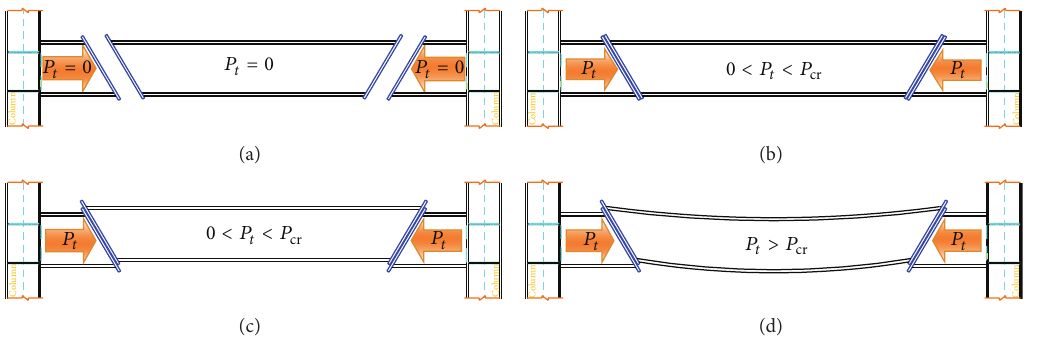
Figure 4: Beam with slant bolted end-plate connection subjected to temperature increase. (a) Stage 1: beam behaviour before increase in temperature. (b) Stage 2: beam behaviour after increase in temperature “two plates are in contact.” (c) Stage 3: Beam behaviour after increase in temperature “two plates contact together and in movement.” (d) Stage 4: Beam behaviour after increase in temperature “buckling and decrease in Young’s modulus.”